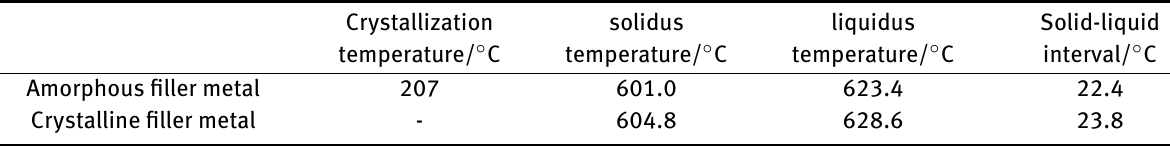
Table 2: Melting temperature of the brazing filler metal